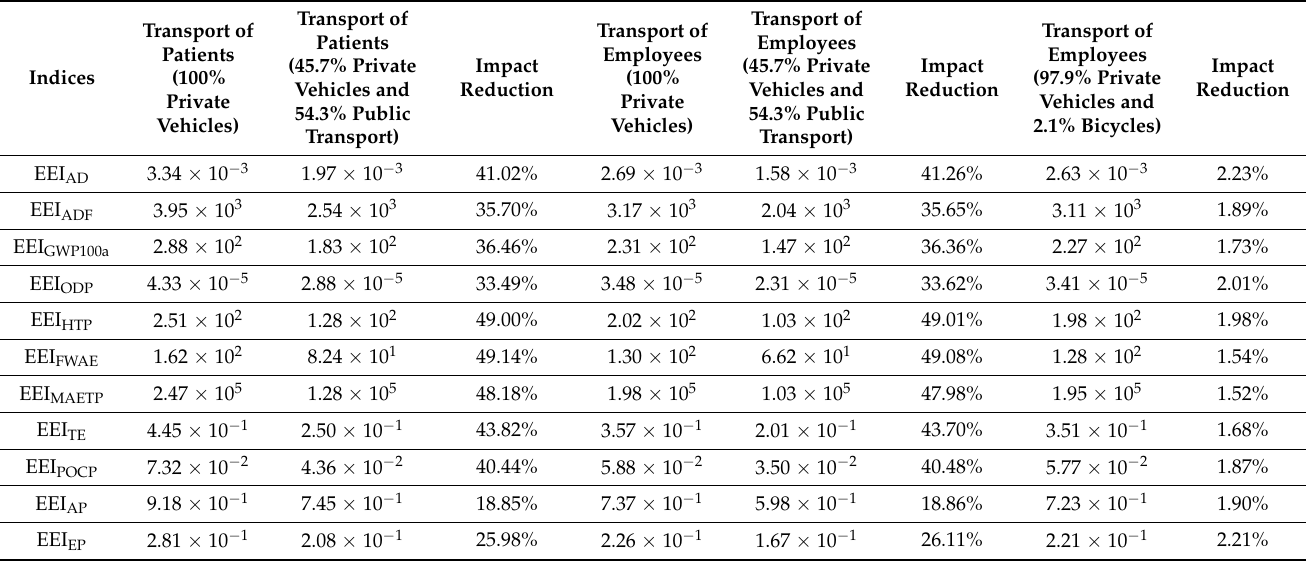
Table 5. Effect of alternative transport scenarios on environmental efficiency indices.